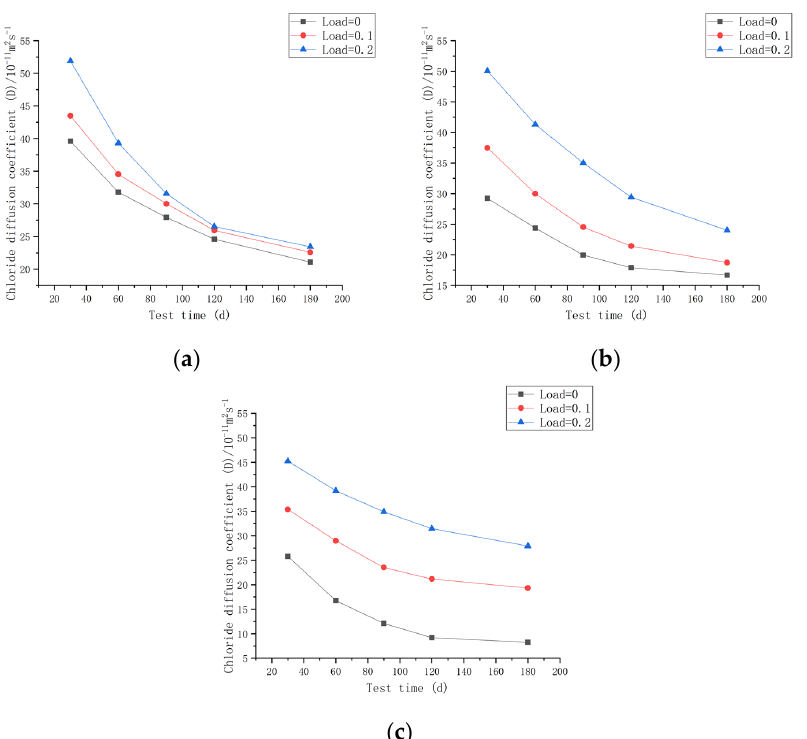
Figure 11. Relationship between D and time for different loads on CASC with the same water–cement ratio at 180 d. ( a ) W/C = 0.30; ( b ) W/C = 0.35; ( c ) W/C = 0.40.